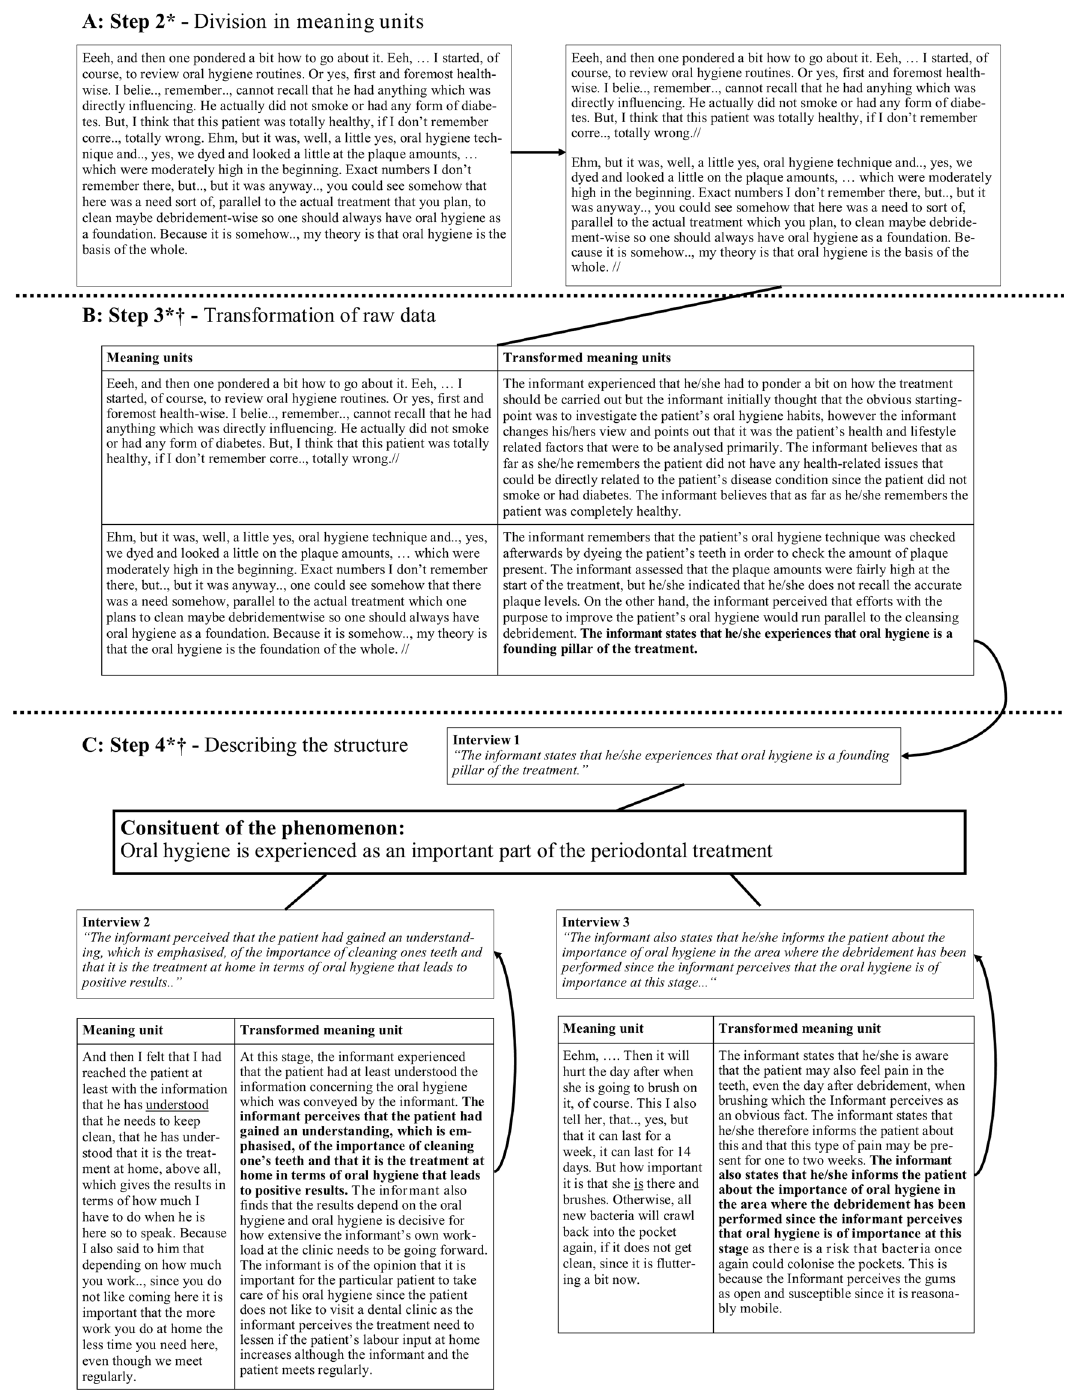
Fig. 1 Simpli fi ed example of the last three methodological steps (steps 2 – 4) in the analysis of the descriptions. A Example of the process of transforming the interview in meaning units. B Example of how raw data is analysed and transformed. C Example of how a part of a general structure is created. *Phenomenological reduction applied in the step. † Eidetic variations applied in the